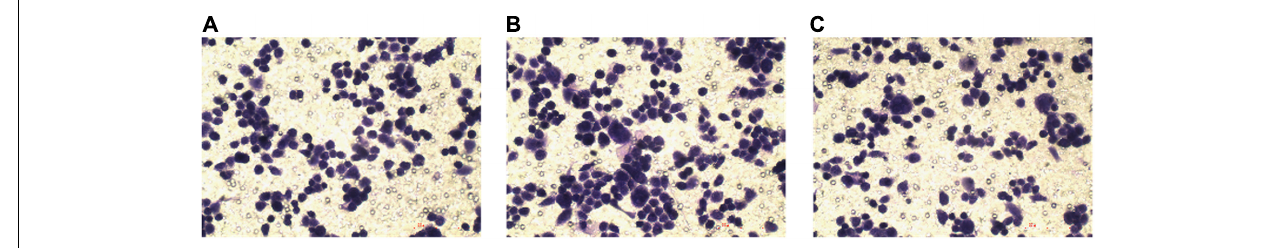
FIGURE 8 | The effect of lncRNA TPA overexpression and knockdown on cell invasion [200 × , (A) Normal breast cancer cells, (B) lncRNA TPA overexpression cells, (C) lncRNA TPA knockdown cells].